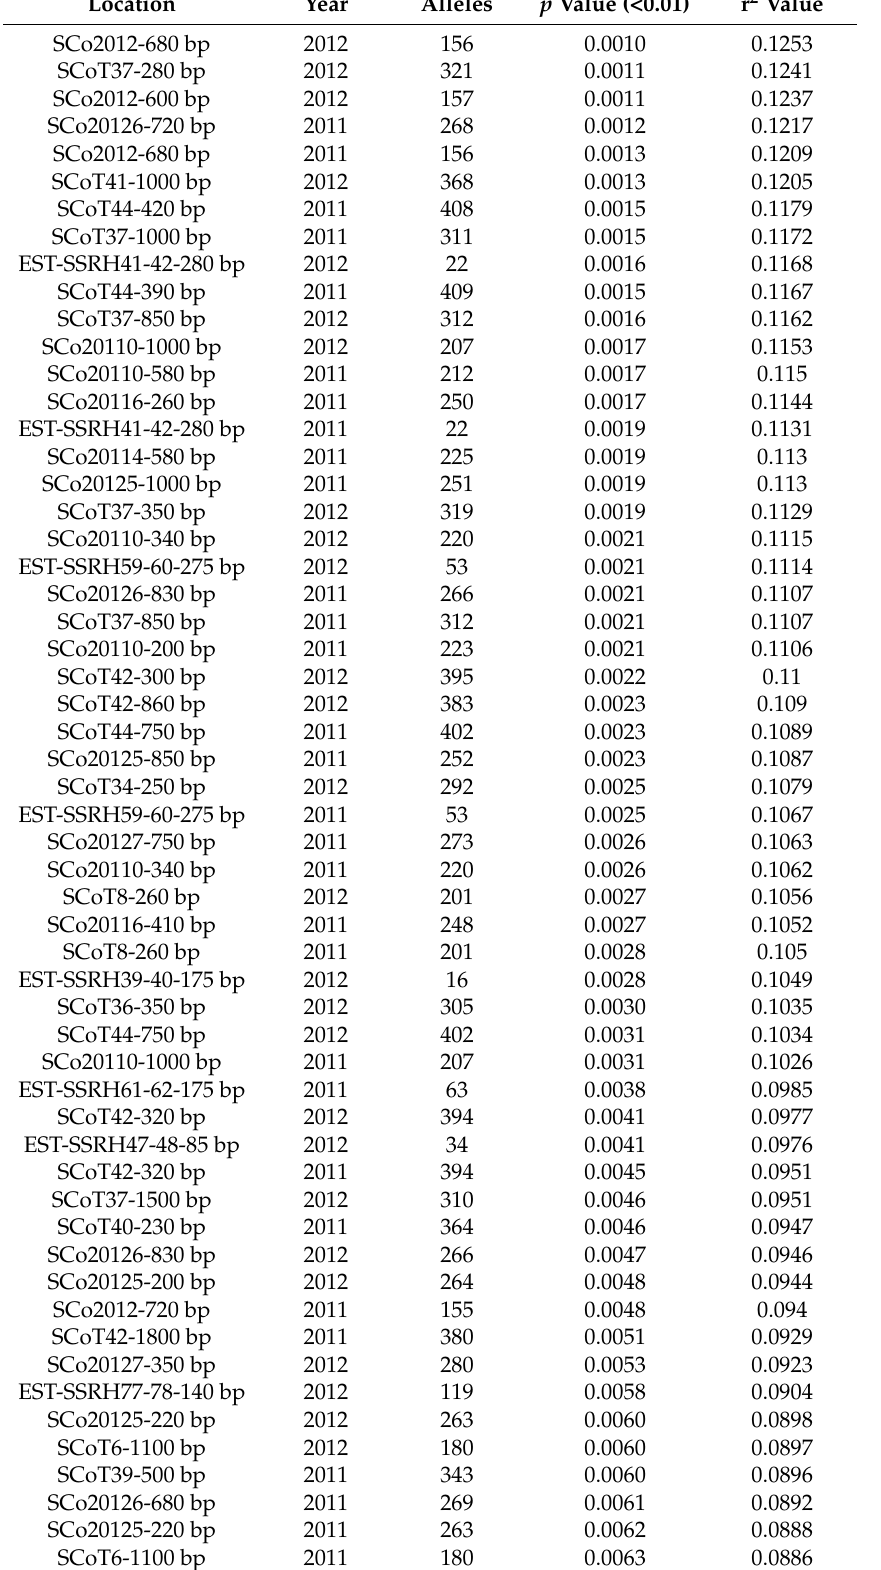
Table 3. Significance test between alleles and phenotypic variation for association analysis in orchardgrass ( p <